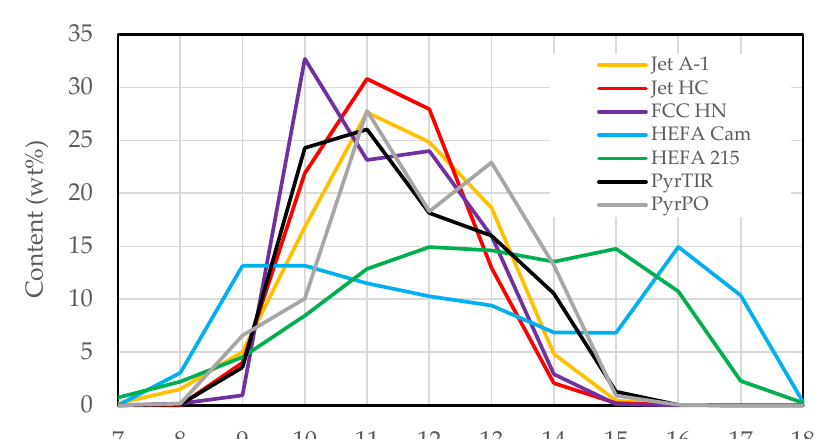
(Figure 2), the smaller the difference in the carbon numbers of the samples.